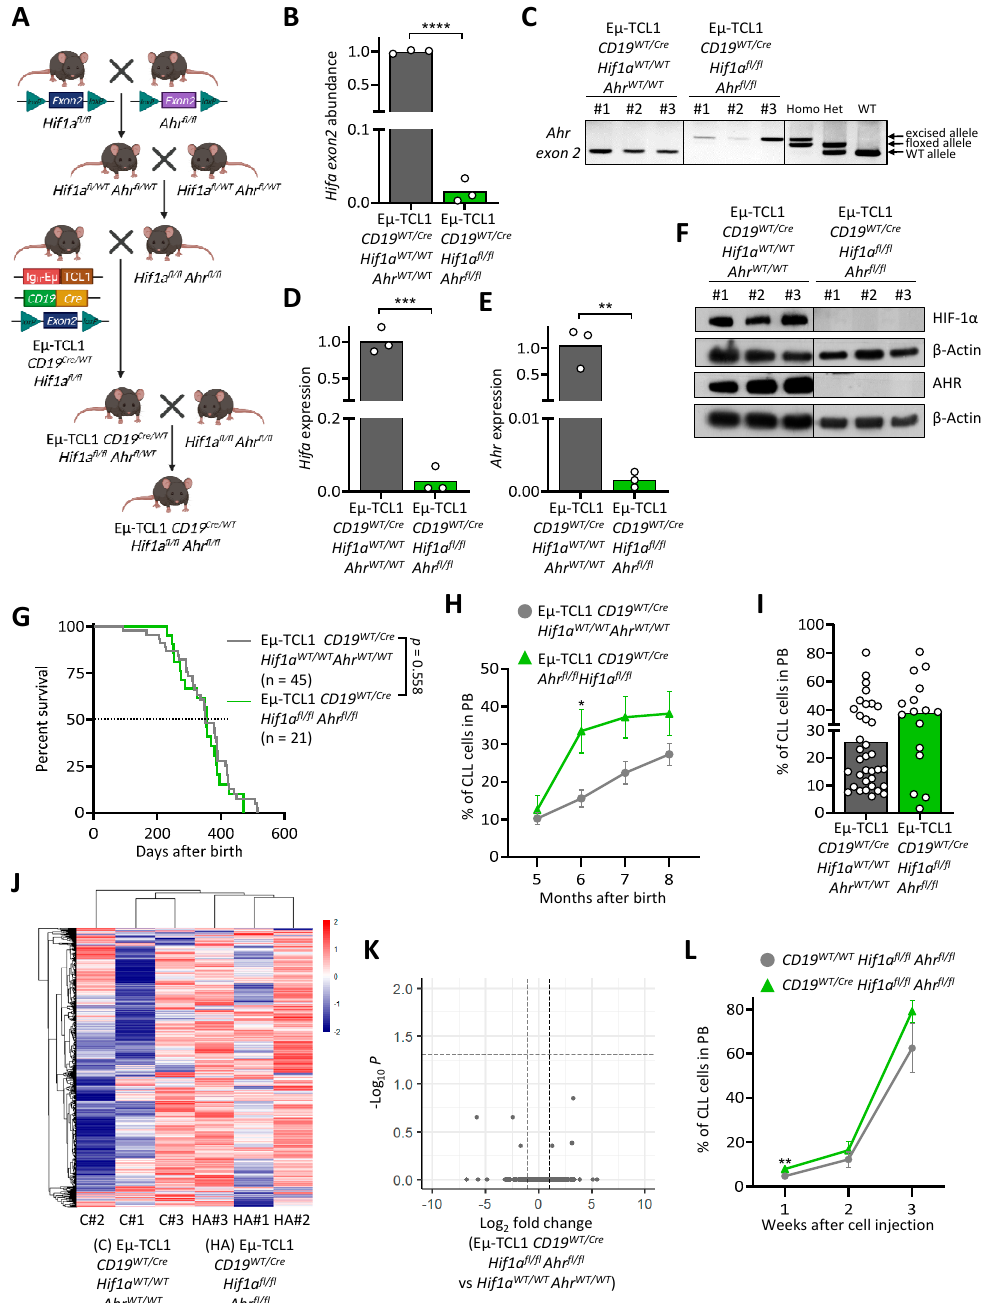
Figure 4. Double knock-out of AHR and HIF-1 α does not appear to have an impact on the development of neoplastic B cells. ( A ) Scheme of the breeding strategy to generate Eµ-TCL1 CD19 Cre/WT Hif1a fl/fl Ahr fl/fl (cDKO) mice. ( B – F ) Validation of the knock-out of exon 2 of Hif1a and Ahr , respectively, in isolated B cells from cDKO mice incubated with CoCl 2 and FICZ at the DNA ( B , C ), RNA ( D , E ), and protein ( F ) levels compared to control mice (n = 3). ** p < 0.01, *** p < 0.001, **** p < 0.0001. ( G ) Survival curve of cDKO compared to control mice shows no significant difference. (Ctrl: n = 45, cDKO: n = 21). (H , I) Flow cytometry analysis of CLL cells (CD19+ CD5+) in the peripheral blood (PB) of cDKO and control mice over time (Ctrl: n = 45, cDKO: n = 21) ( H ) and at month 8 (Ctrl: n = 35, cDKO: n = 16) ( I ). ( J , K ) CLL cells from cDKO and control mice (n = 3) were subjected to RNA sequencing. ( L ) Unsupervised hierarchical clustering showing the top10,000 most expressed genes. ( I ) Volcano plot showing DEG between cDKO and control mice. ( J ) CLL development of the adoptive transfer of Eµ-TCL1 CLL cells in CD19 Cre/WT Hif1a fl/fl Ahr fl/fl mice (Ctrl: n = 4, cDKO: n = 4).